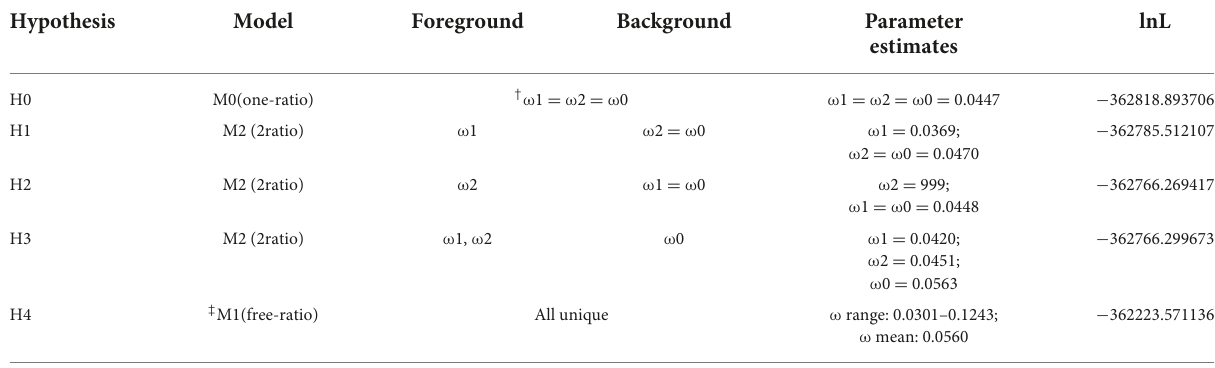
TABLE 5 Parameter estimates and likelihood scores from branch models for the variation of ω among branches within Discosea based on the concatenated genes.